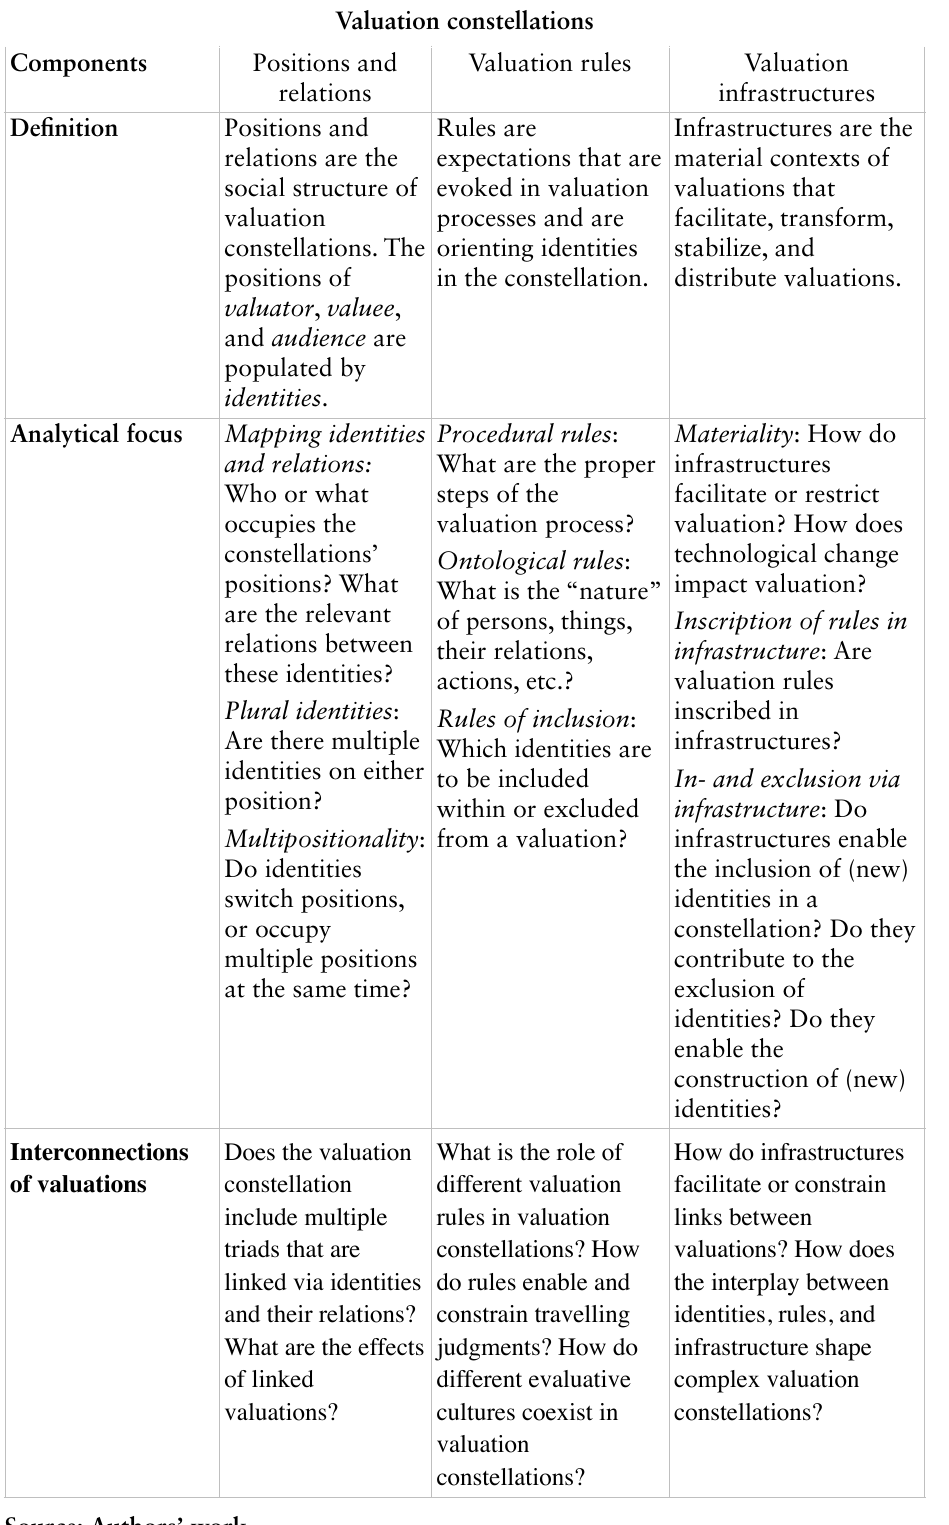
Table 1. Components of valuation